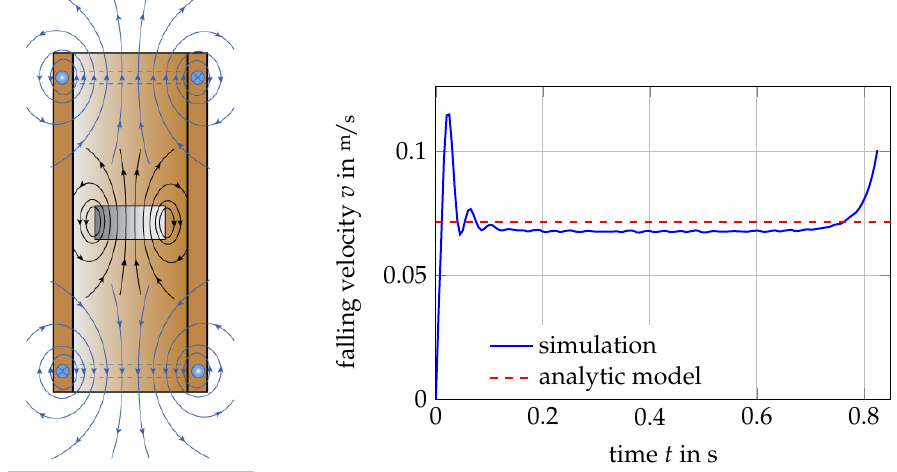
Figure 9. Falling magnet in a copper tube: mechanism ( left ), falling velocity ( right ).